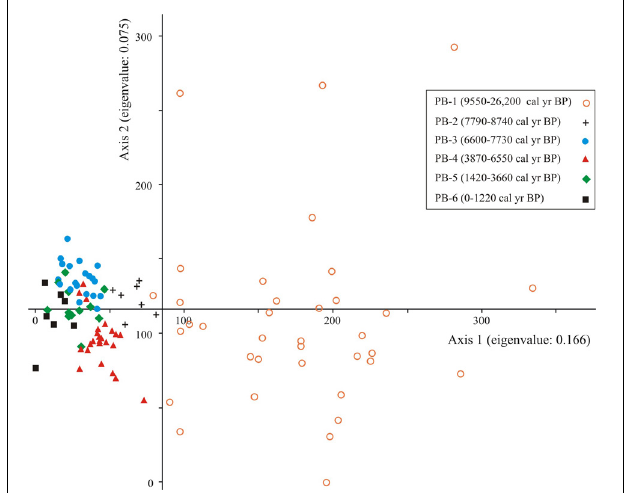
FIGURE 3 | Ordination results of Axes 1 and 2 of the DCA of presence/absence fossil pollen data for the Paul’s Bog dataset (26,200-0 cal. year BP). To reduce noise in the dataset, the rarest types were removed. Samples from similar age periods were